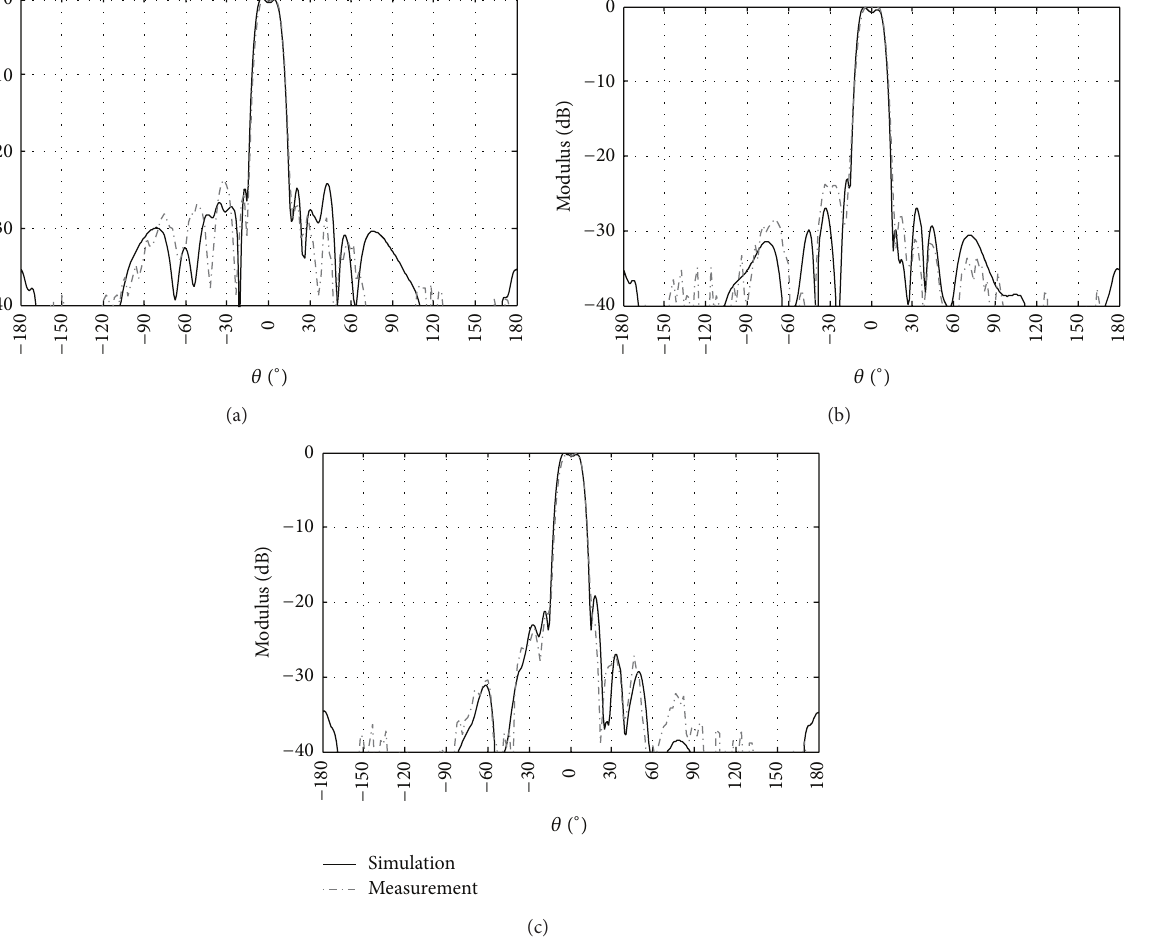
Figure 14: Comparison between simulated and measured normalized sectorial radiation patterns at broadside direction: (a) 8 GHz, (b) 8.2 GHz, and (c) 8.4